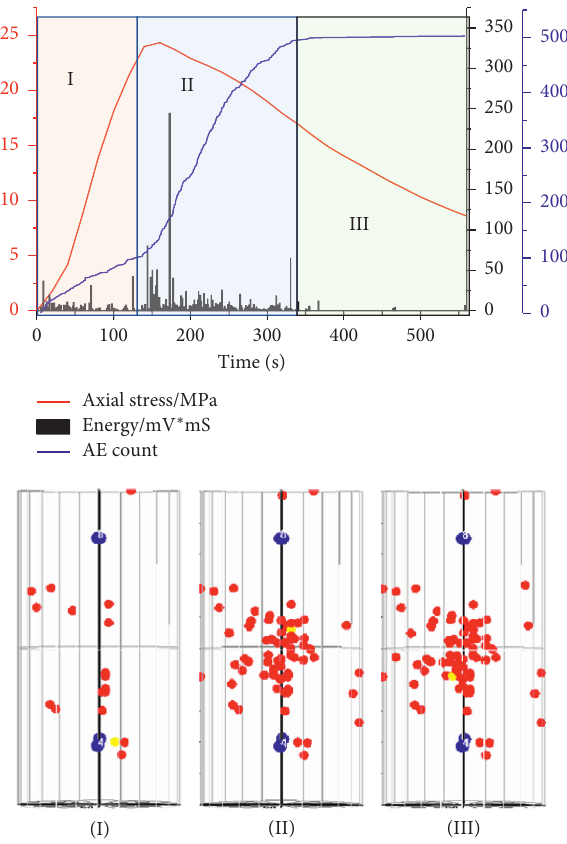
Figure 6: The four-parameter-time relationship for wet shotcrete.